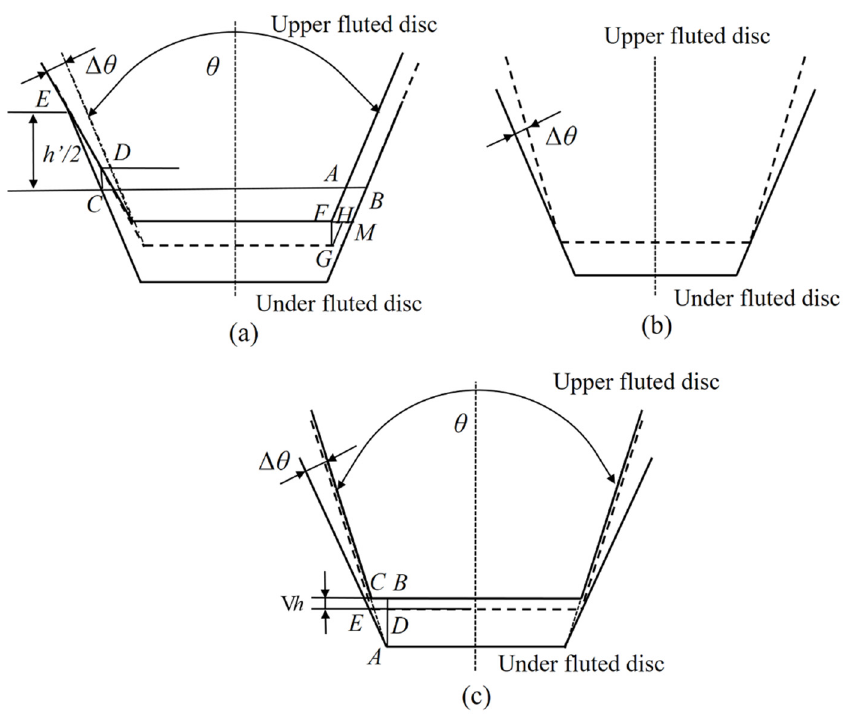
Figure 4. Schematic diagrams of tooth profile half-angle errors in the meshing state. ( a ) The under fluted disc is standard and the deviation of the actual half-angle of the upper fluted disc is biased to the outside of the axis. ( b ) The under fluted disc is standard and the deviation of the actual half-angle of the upper fluted disc is biased to the inside of the axis. ( c ) The upper fluted disc is standard and the deviation of the actual half-angle of the under fluted disc is biased to the outside of the axis. (c) Type 3: The upper fluted disc is standard. The deviation of the actual half-angle of the under fluted disc from the standard half-angle is ∆ θ and it is biased to the inside of the axis. In this case, the calculation method is the same as Type 1 and it can be calcu- lated by changing the corresponding parameters.